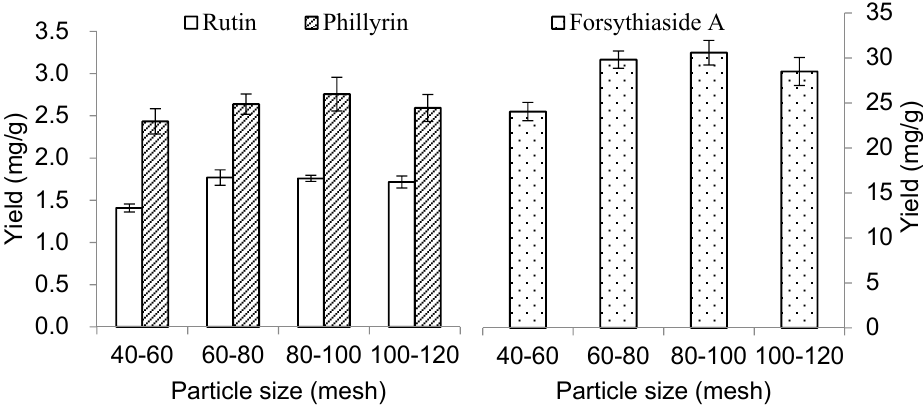
Figure 4. Effect of particle size on the extraction yields of forsythiaside A, rutin and phillyrin. The value of forsythiaside A is shown on the secondary y -axis on the right.